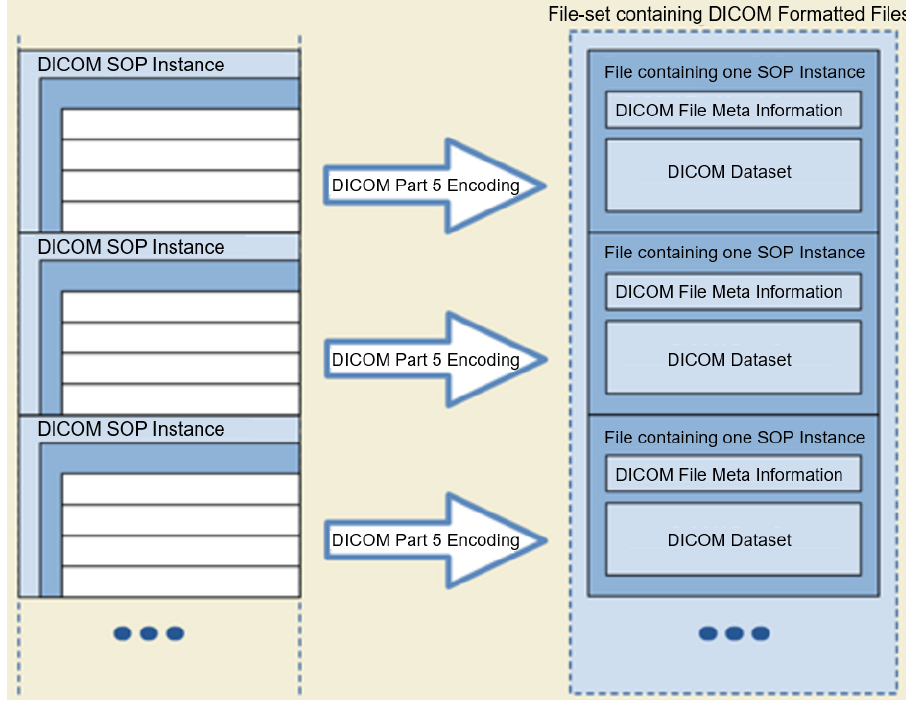
Figure 1. DICOM File-set and File Format (adopted from the DICOM standard, Chapter